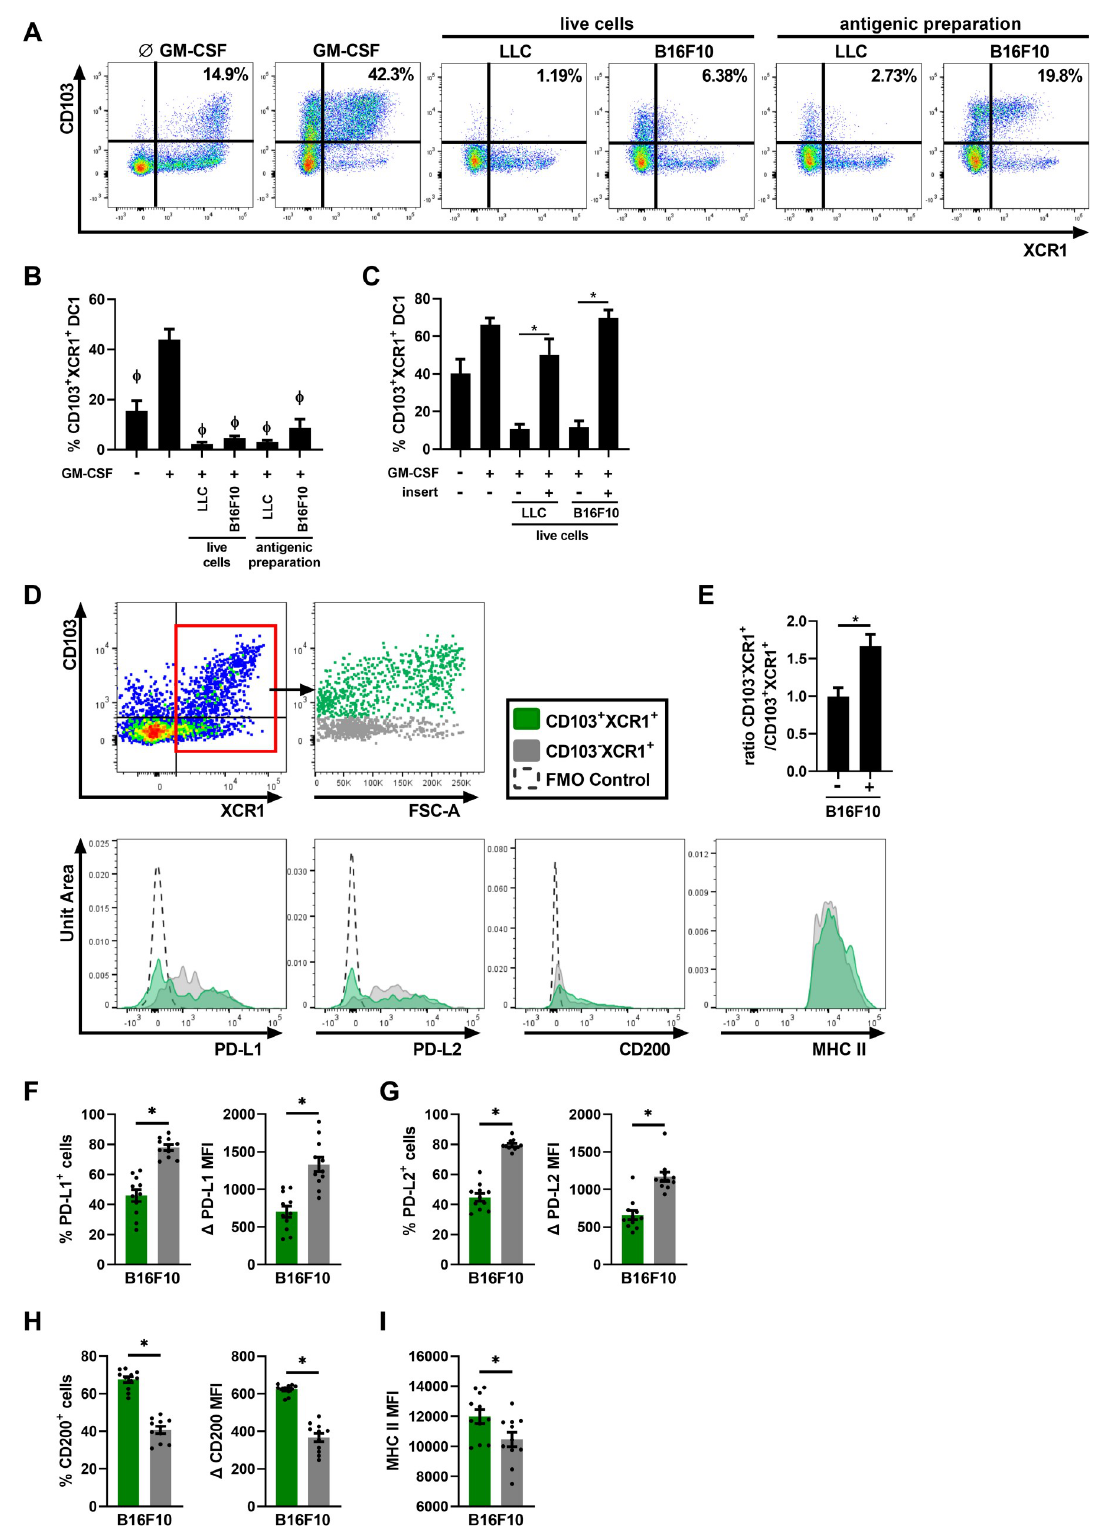
Fig 2. Cancer cells prevent the differentiation of bone marrow precursors into CD103 + XCR1 + DC1s. (A-C) FLT3L-BMDCs were exposed to GM-CSF ± live B16F10/LLC cells or a B16F10/LLC antigenic preparation (A and B). In C), DCs were segregated (or